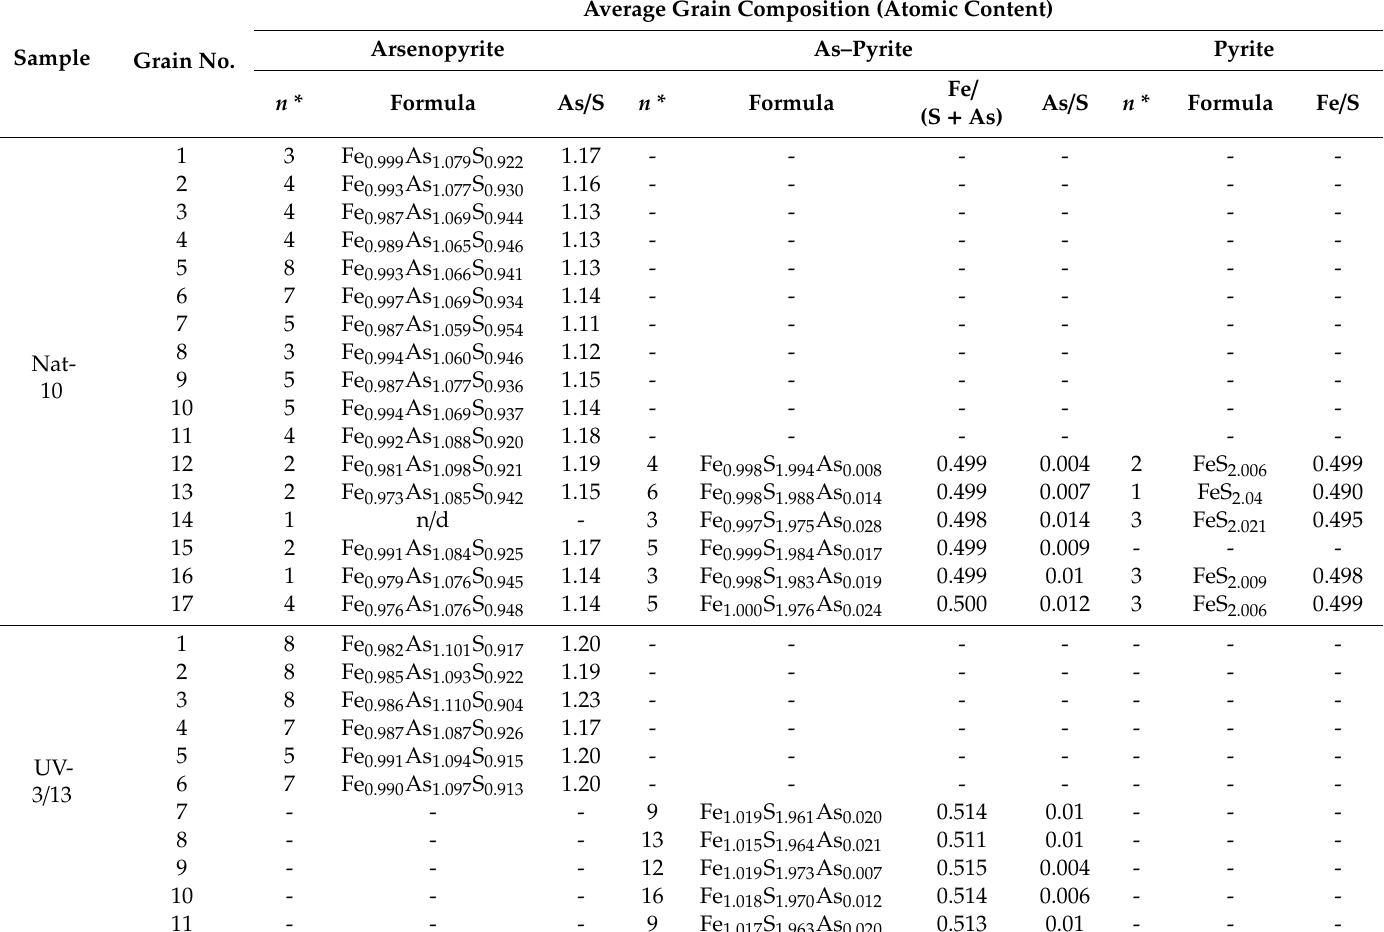
Table 2. EPMA data for arsenopyrite and pyrite